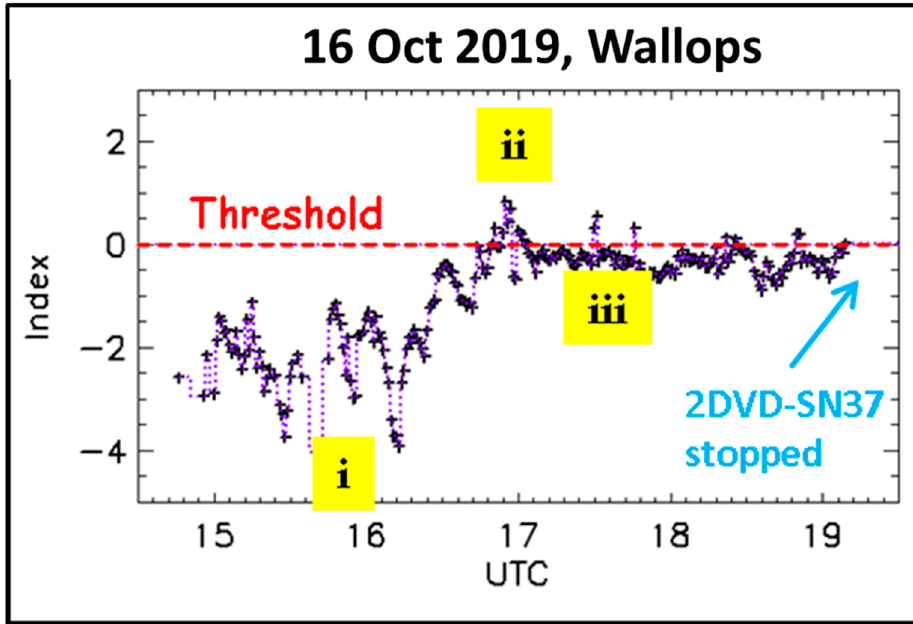
Figure 7. Variation of the ‘index’ parameter with time for the 16 October 2019 event. Cases (i), (ii), and (iii) are marked where the index indicated stratiform, convective, and ‘mixed’ or ‘uncertain’ rain, respectively.